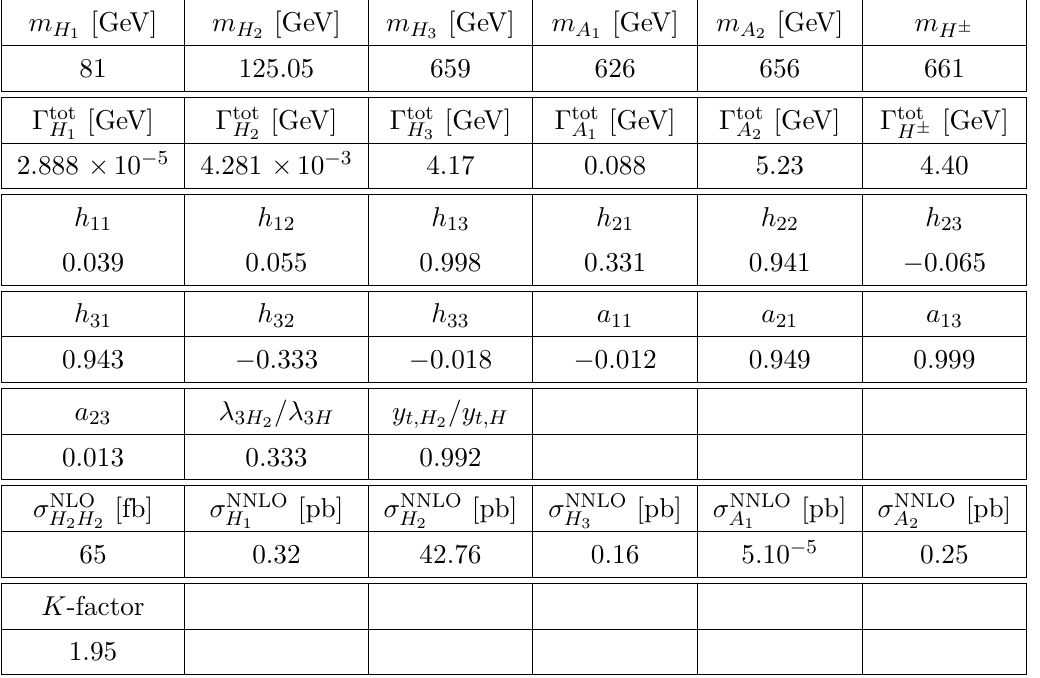
Table 20 . BP11 : additional information related to double and single Higgs